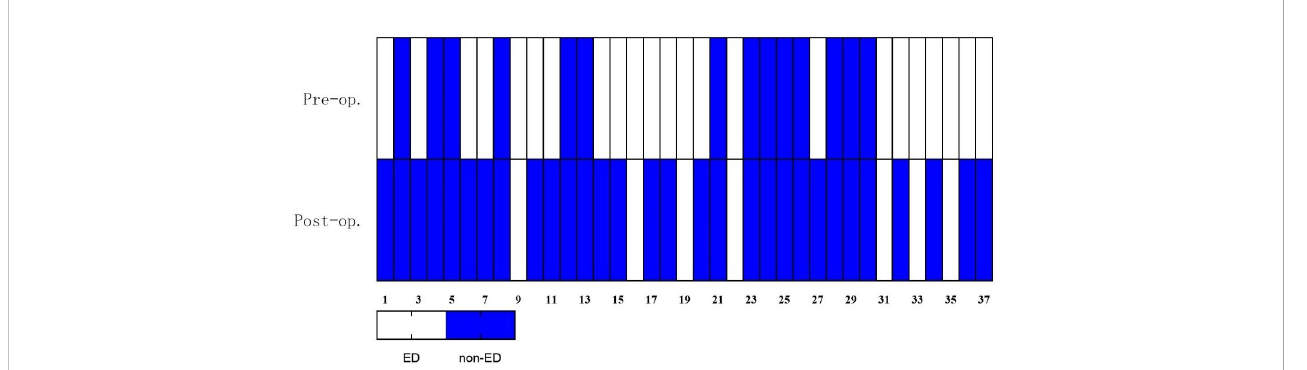
FIGURE 4 Heatmap: changes in EF domain based on erectile dysfunction classi fi cation. ED is diagnosed if EF scores ≤ 25. Patients with ED decreased from 27 (73.0%) to 11 (29.7%). EF, erectile function; ED, erectile